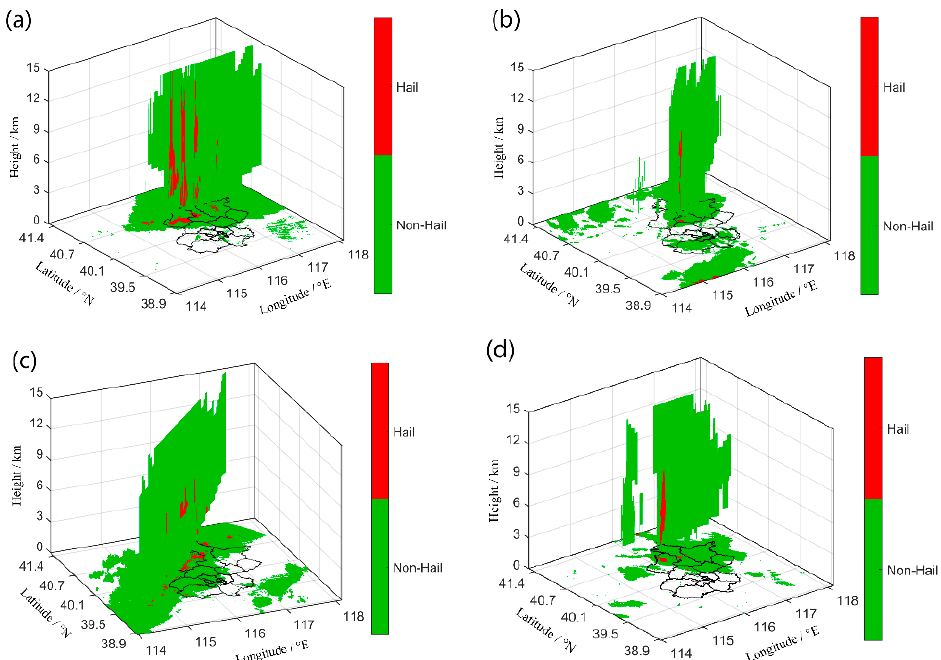
Figure 9. Vertical cross section of hail (unit: km) derived from the radar in Beijing. ( a ) Vertical cross section of hail derived from the radar at 20:00 BJT on 25 June 2021; ( b ) vertical cross section of hail derived from the radar at 16:00 BJT on 30 June 2021; ( c ) vertical cross section of hail derived from the radar at 16:00 BJT on 1 July 2021; ( d ) vertical cross section of hail derived from the radar at 17:00 BJT on 9 August 2021.